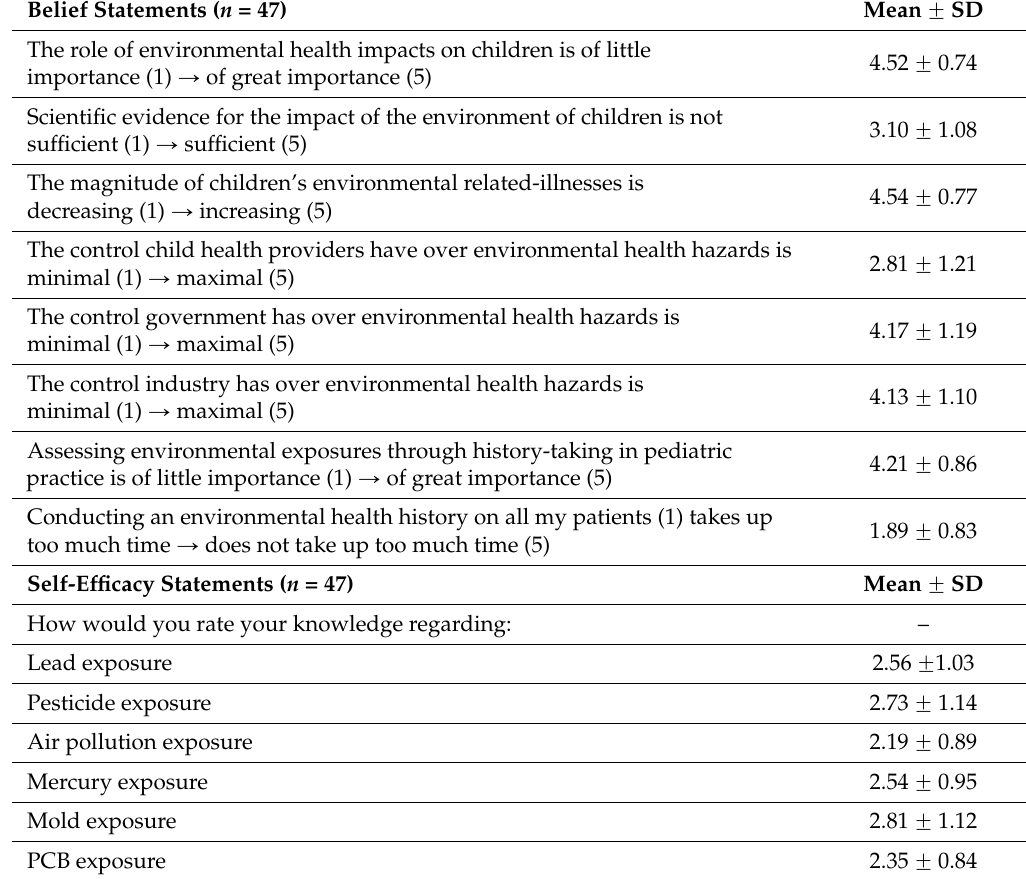
Table 4. Conference participant self-reported beliefs and self-efficacy regarding environmental